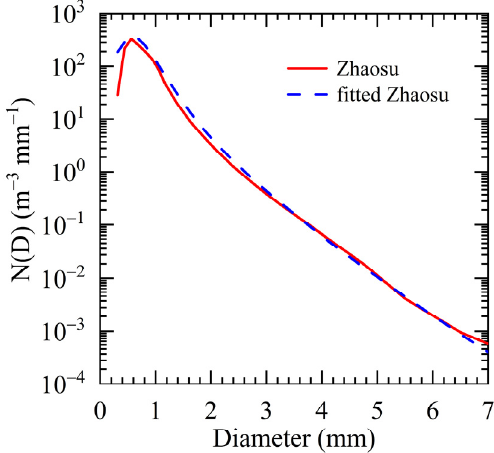
Figure 3. Mean raindrop concentrations (solid red line) and the fitted normalized gamma distribution (dashed blue line) in Zhaosu. Table 1. Several important rainfall parameters for all samples.